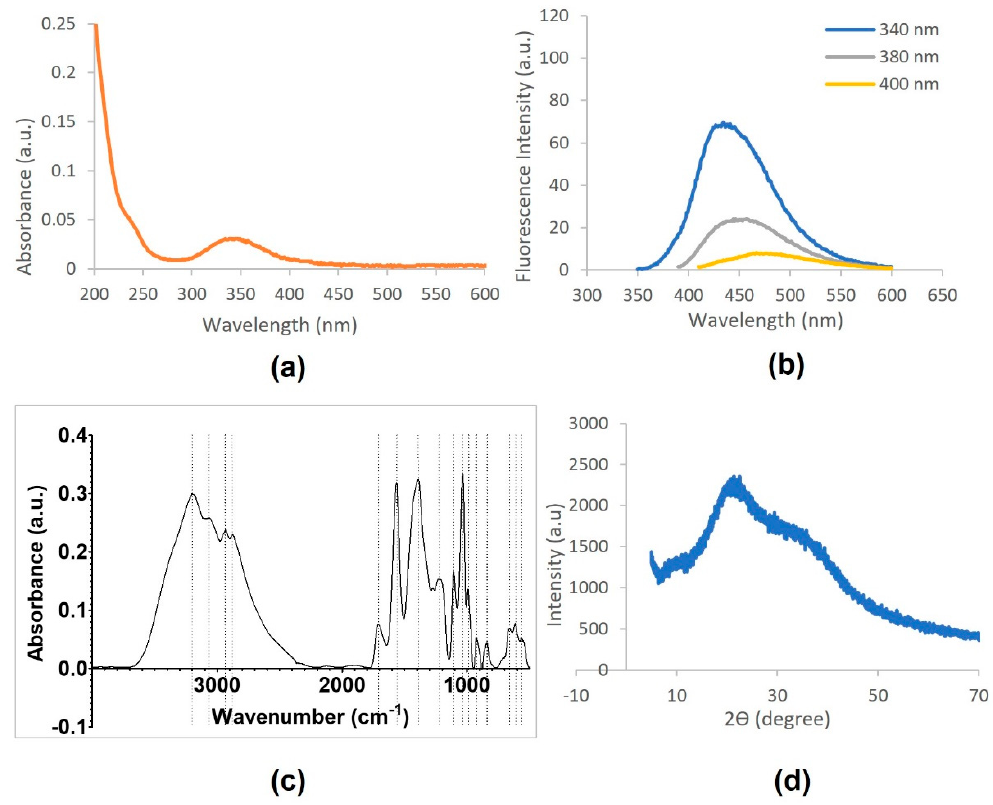
Figure 2. Characterization of CD by ( a ) UV-visible absorption; ( b ) fluorescence; ( c ) FTIR-ATR; and ( d ) XRD.